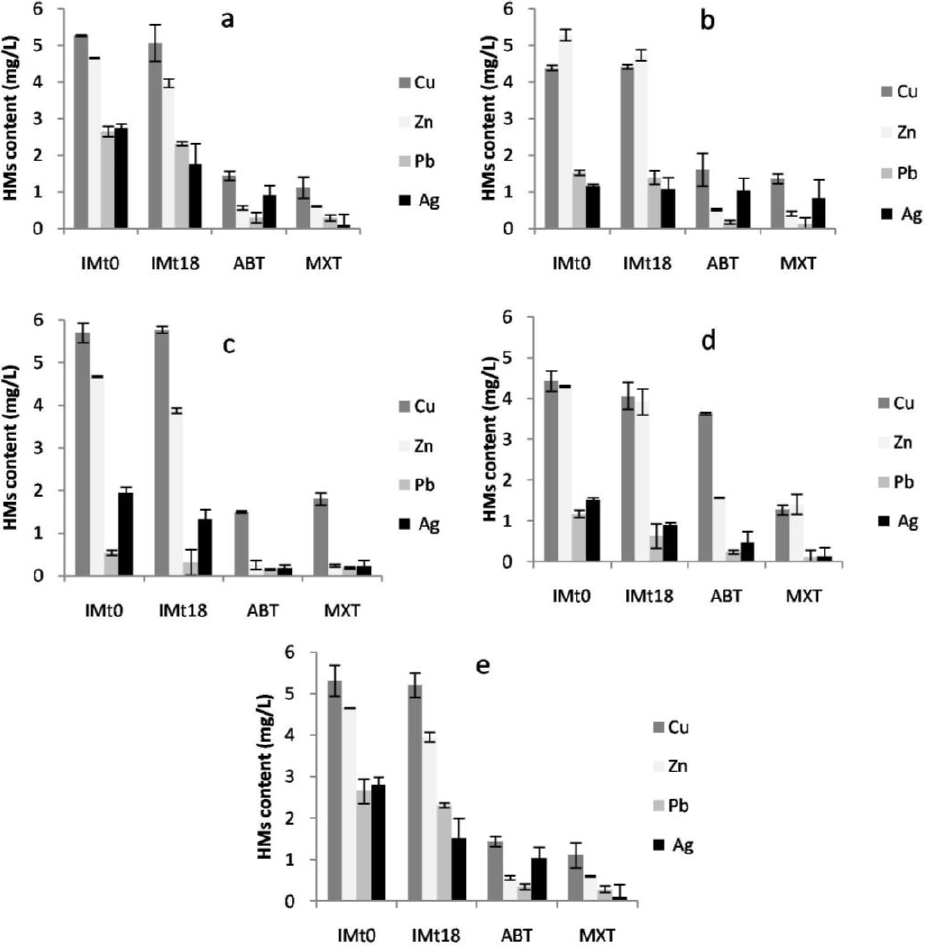
Figure 3. Residual concentrations of Cu, Zn, Pb, and Ag, expressed in mg/L in the culture medium of inactivate mycelium (IM), and for each fungus in the presence of PAH (MXT) and ABT for ( a ) C. jodhpurense , ( b ) C. maderasense , ( c ) P. variabile , ( d ) E. lacerata , and ( e ) P. betae after18 days of incubation. Error bars indicate the average of tree replicates (n = 3).